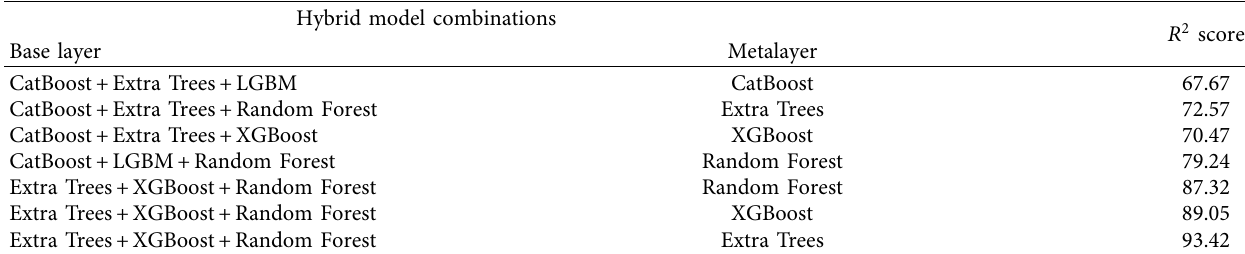
Table 4: Comparison of the proposed approach with different